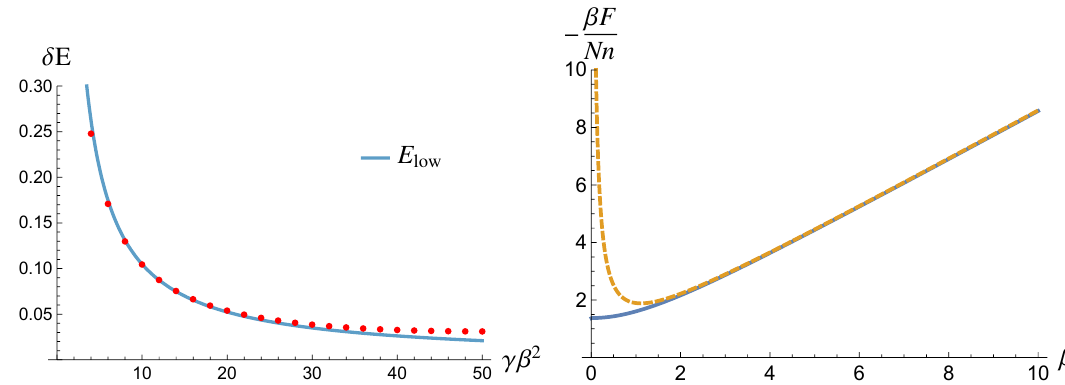
Figure 3 . Left : plot of (cid:14)E ( (cid:12) ) = h E ( (cid:12) ) i(cid:0) E 0 and the (cid:16) -regularized value E low . We have performed the sum in (4.4) numerically using the exact expression for S a ( ! n ) and cuto(cid:11) our sum above and below at n c = (cid:6) 2 : 5 (cid:2) 10 3 . As n c increases the plots become increasingly close. Right : comparison between numerically computed (cid:0) (cid:12)F=Nn obtained by evaluating the on-shell action (solid curve) and the low temperature approximation (cid:0) (cid:12)E 0 + C ( (cid:12) ) = 2 (dashed curve). At low temperatures these curves align implying that the zero temperature entropy S 0